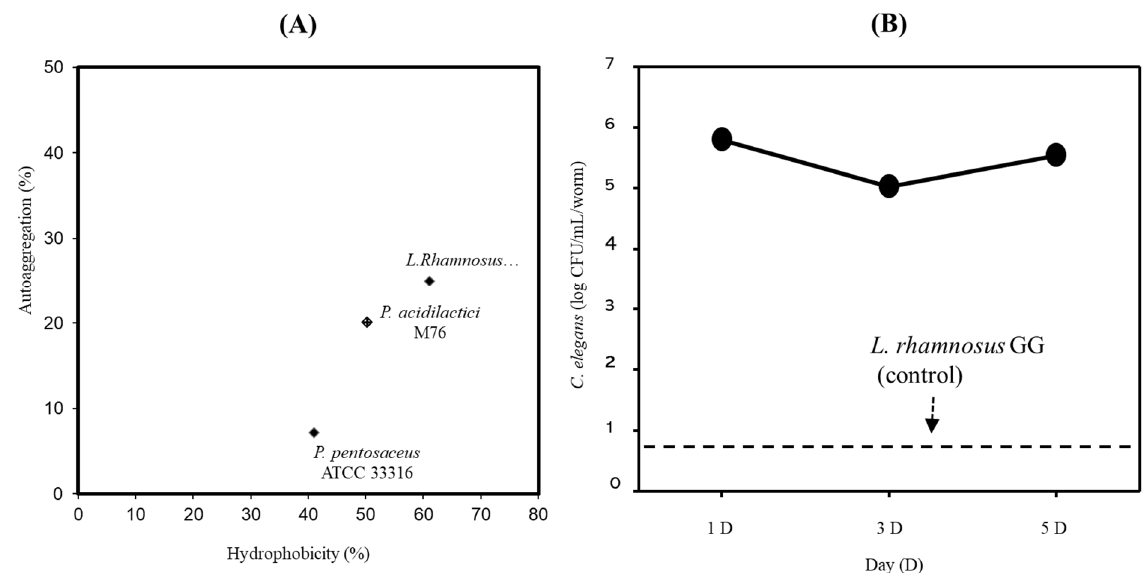
Figure 1. ( A ) Correlation of the hydrophobicity and coaggregation results of the lactic acid bacteria strains. ( B ) Adhesion activity of Pediococcus acidilactici M76 in the intestine of Caenorhabditis elegans .